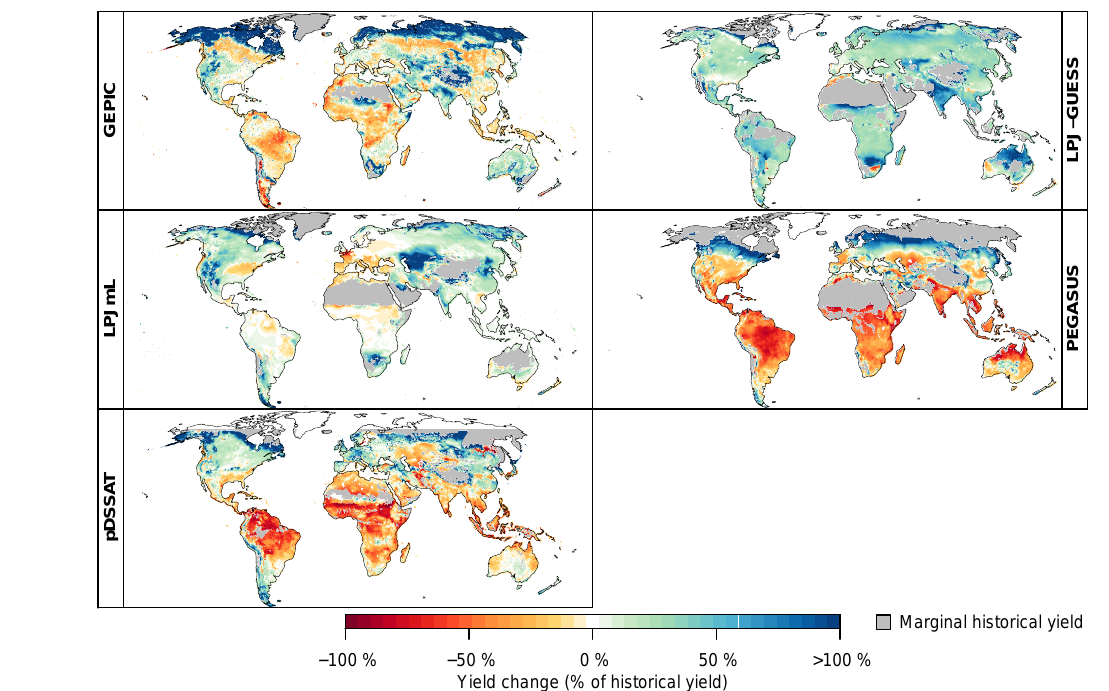
Figure 2. Average wheat yield change at (cid:49) GMT = 2.5 ◦ C as a percentage of the mean historical yield (1980–2010 average) under rain-fed conditions for each crop model forced by HadGEM2-ES. The average is calculated across all RCPs which reach the global mean warming interval from 2.25 to 2.75 ◦ C, namely RCP4.5, RCP6.0, and RCP8.5. Note that pDSSAT is run over a limited domain excluding areas north of 60 ◦ N. Regions with marginal historical yields (defined as lying below the 2.5% quantile of historical yields on year-2000 cropland) are masked to avoid exaggerated relative yield increases. Analogous figures for different crops, for irrigated conditions, and for absolute yield change (in tons per hectare) are available in the